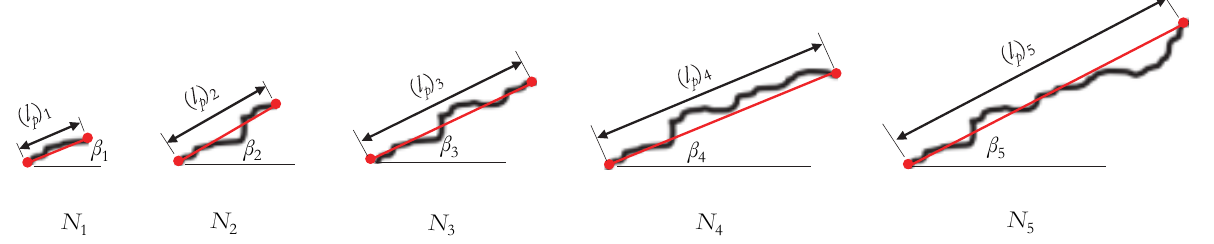
Figure 1: Definition of the projected crack length, l p , and its orientation, β . N i+1> N i.